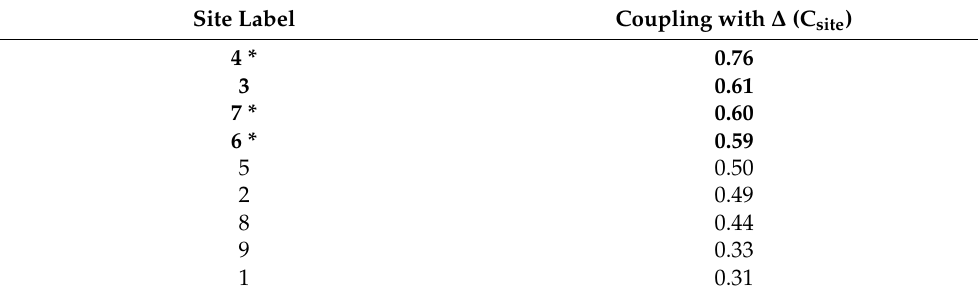
Figure 4. β 2AR sites couplings to ∆ . Sites on the surface of β 2AR are represented by spheres, that are colored according to C site , the coupling strength (from blue, denoting weaker coupling, to red, indicating stronger coupling). Sites 4, 6 and 7 correspond to known allosteric sites (see Figure 1a–c). Table 1. Ranking of β 2AR sites based on the strength of their coupling to Δ .